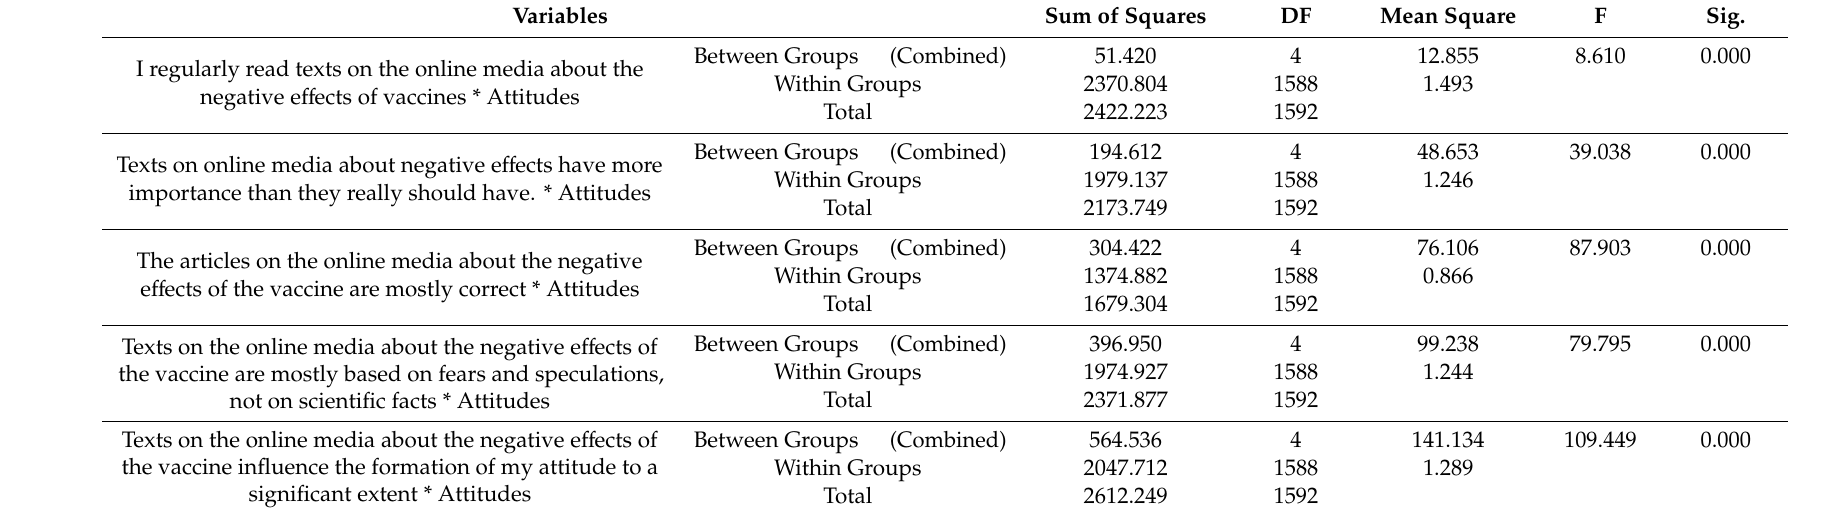
Table 6. ANOVA test of determination of online media on parent’s attitudes.